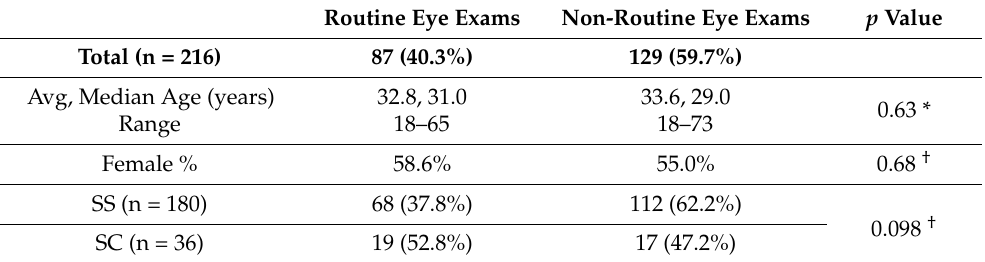
Table 3. Retinopathy − screening data from